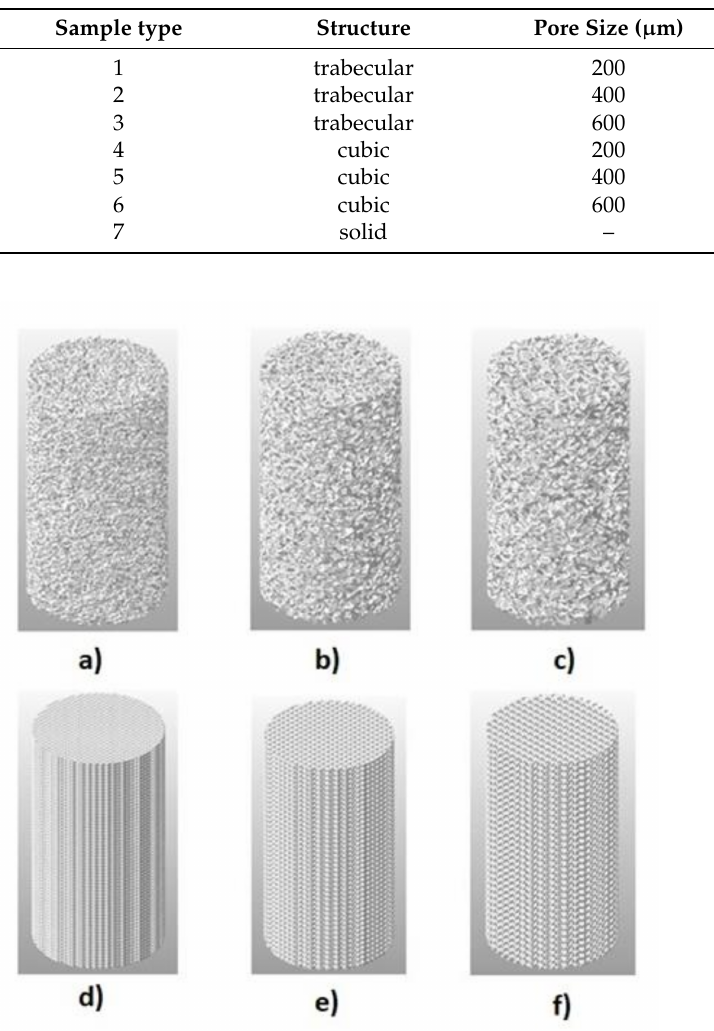
Table 3. Characteristic parameters of the tested specimens.